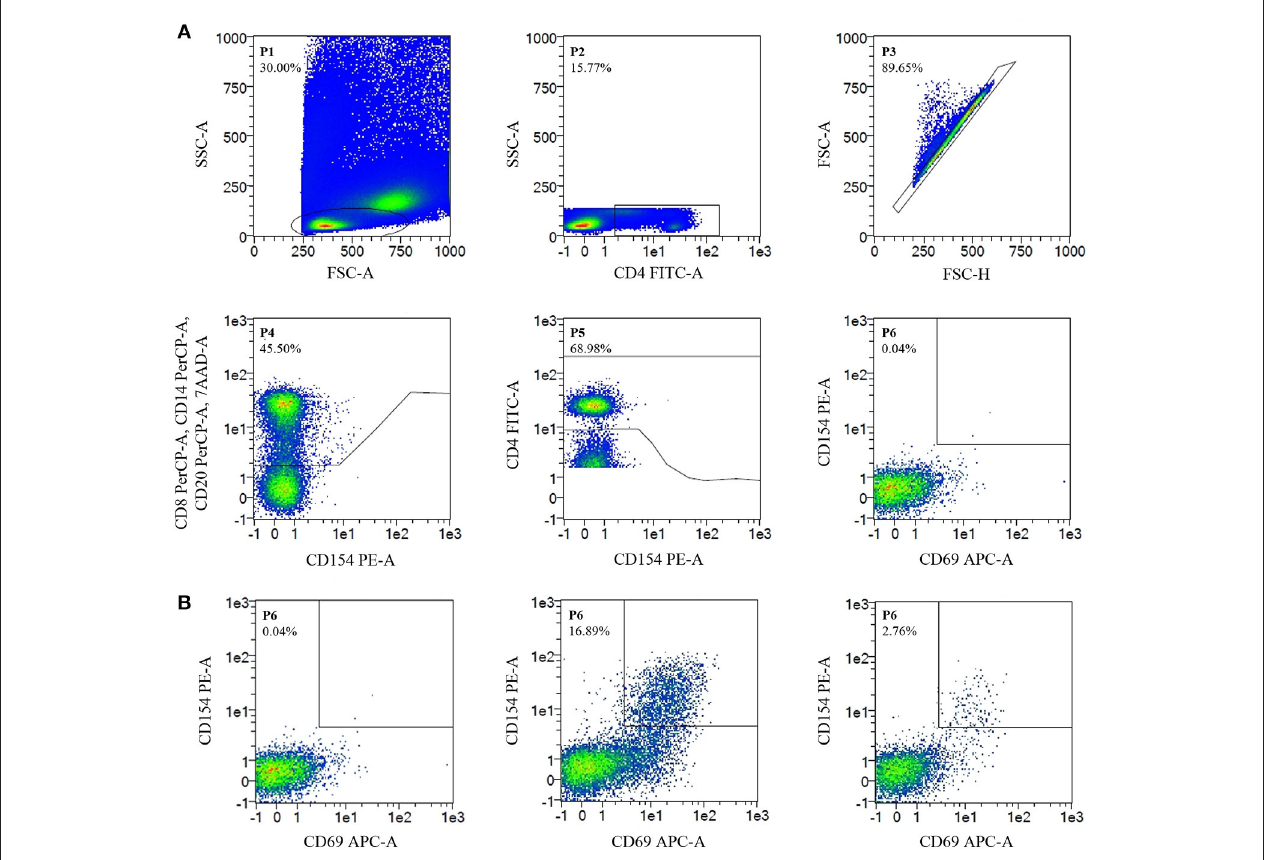
FIGURE 2 | Flow Cytometry-Gating strategy and detection of C. glabrata -reactive T cells. Cell frequencies (%). (A) Gating strategy. Negative control, unstimulated CD4 + T cells, show no CD69/CD154 expression. (B) Detection of C. glabrata -reactive T cells. From left to right. Negative control; positive control (staphylococcal